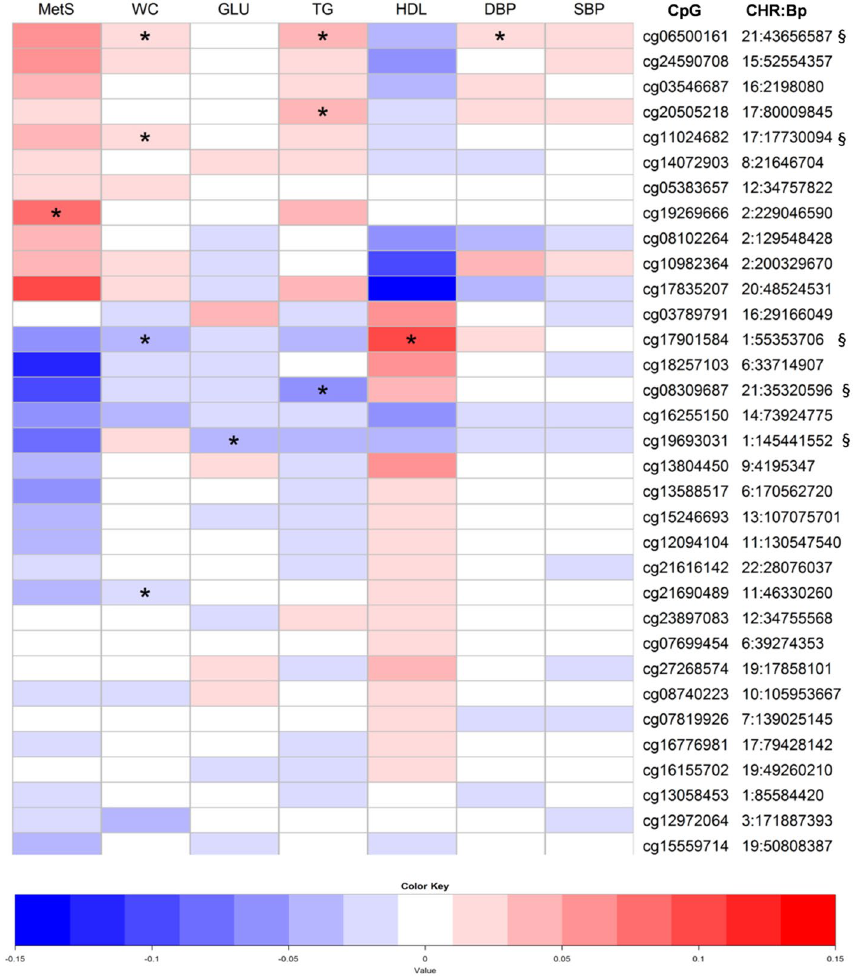
Figure 2. Association of CpG methylation sites across metabolic syndrome (MetS) and related phenotypes in the NFBC1966 cohort. The heat map includes the 33 most significant probes from the discovery epigenome- wide association studies (EWAS). Colours in the map refer to the effect size (beta) values for the probe in question. Beta values exceeding 0.15 are recoded as 0.15 and values below –0.15 are recoded as –0.15 in the figure. Stars indicate significant P values from the individual tests as follows: * P < 0.01, ** P < 0.0001, *** P < 1 × 10 −6 . Beta values from the waist circumference, diastolic blood pressure, and systolic blood pressure analyses are multiplied by 10 in order to provide more comparable and clinically relevant values for beta in the heat map. The detailed numeric data for the heat map is presented in the Supplementary Table 2. § indicates the successful replication of the association between the methylation probe and the individual phenotype. MetS metabolic syndrome as case/control, WC waist circumference, GLU fasting glucose, HDL high-density lipoprotein, TG triglycerides, DBP diastolic blood pressure, SBP systolic blood pressure, CpG cytosine–guanine dinucleotide, CHR chromosome, Bp base